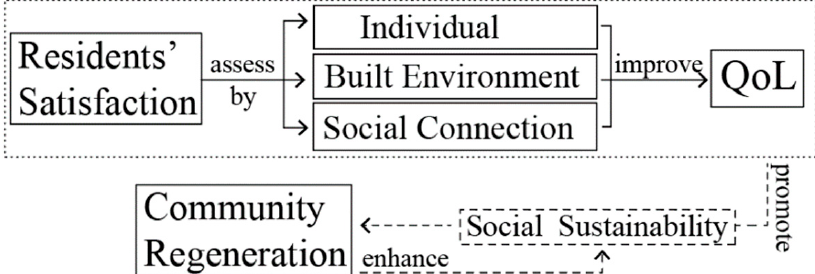
Figure 2. Resident satisfaction evaluation for social sustainability and community regeneration.